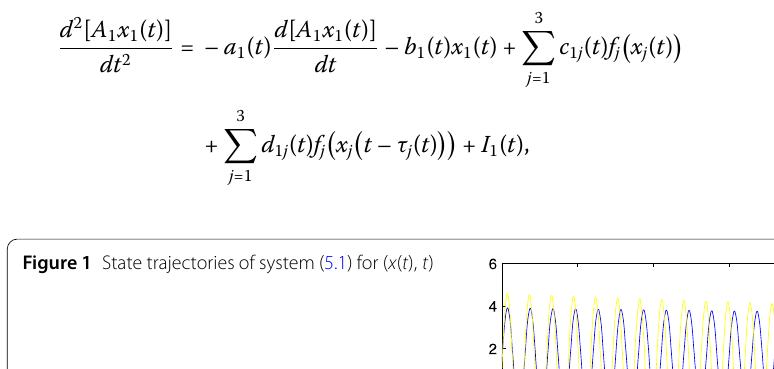
Figure 1 State trajectories of system (5.1) for ( x ( t ), t